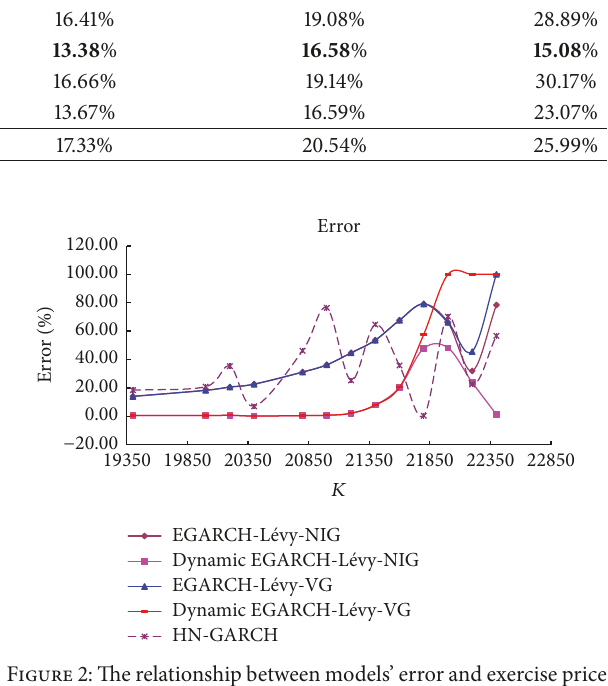
Figure 2: The relationship between models’ error and exercise price in middle-term